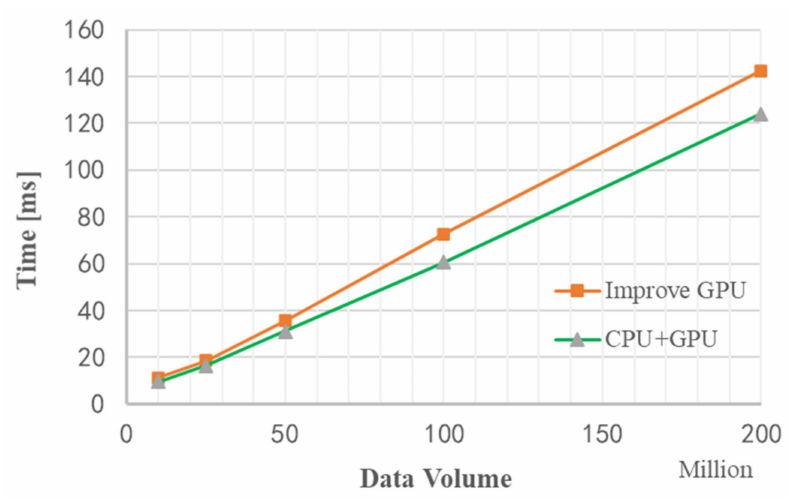
Figure 20. Comparison of GPU time spent on stream acceleration processing and improved algorithm.